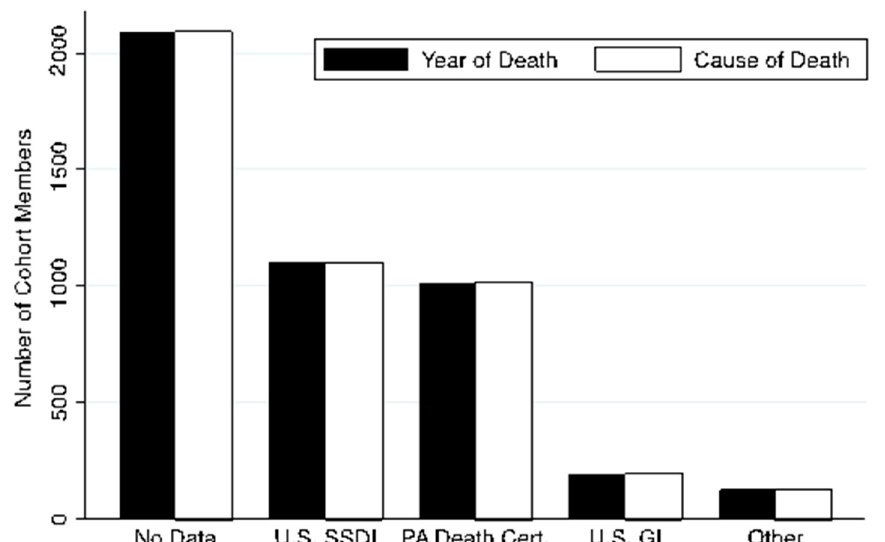
Figure 4. Distribution of information acquisition of death-related databases. U.S. SSDI = United States Social Security Death Index; PA Death Cert = Pennsylvania Death Certificates; U.S. GI = United States Grave Index.